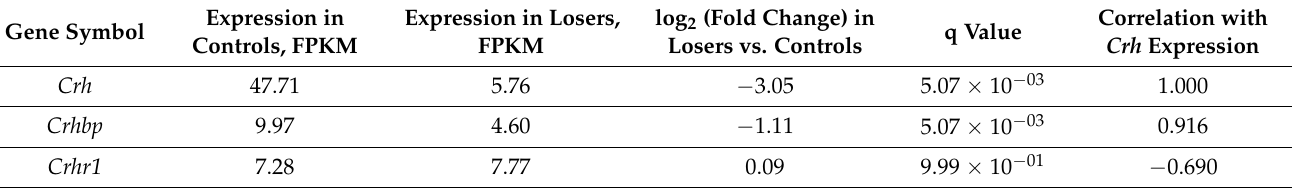
Table 6. The expression of genes encoding receptors for CRH or TRH or encoding the proteins that implement their inactivation as well as